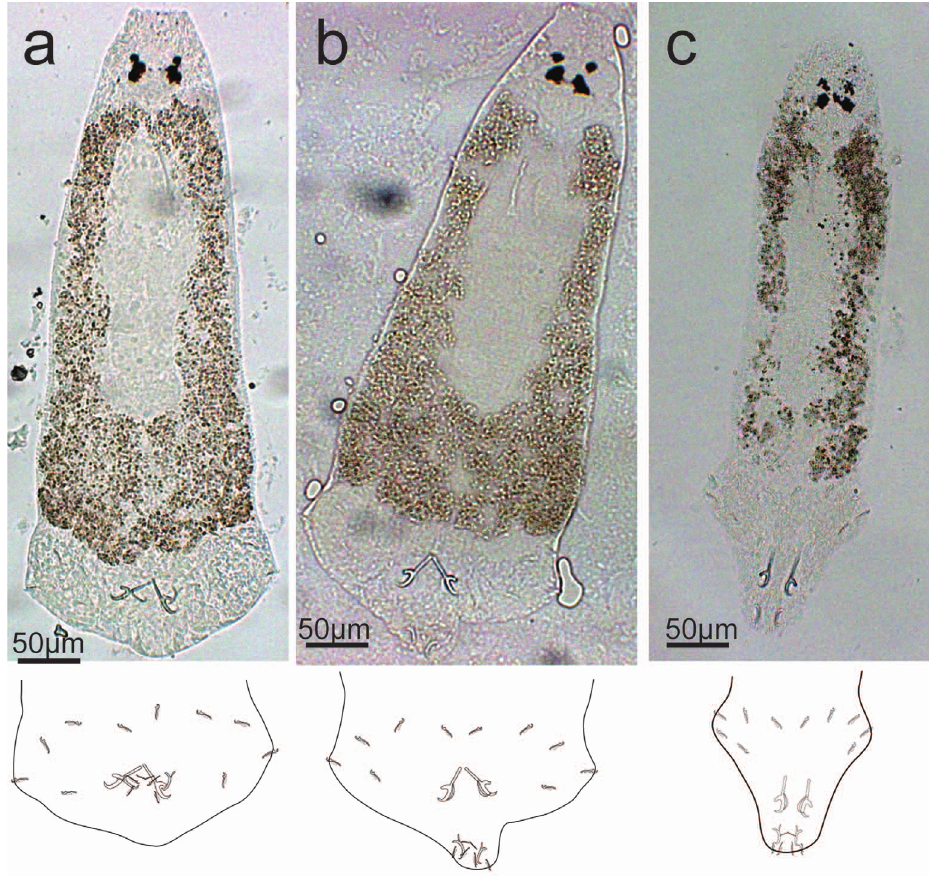
Figure 4. Different body shape of E. coronatus Pariselle, Lambert & Euzet, 1991 under coverslip and the motion of opisthaptoral sclerotized parts depicted in drawings. (a) Cup-shaped body (retracted); (b) interim body shape; (c) tongue-shaped body